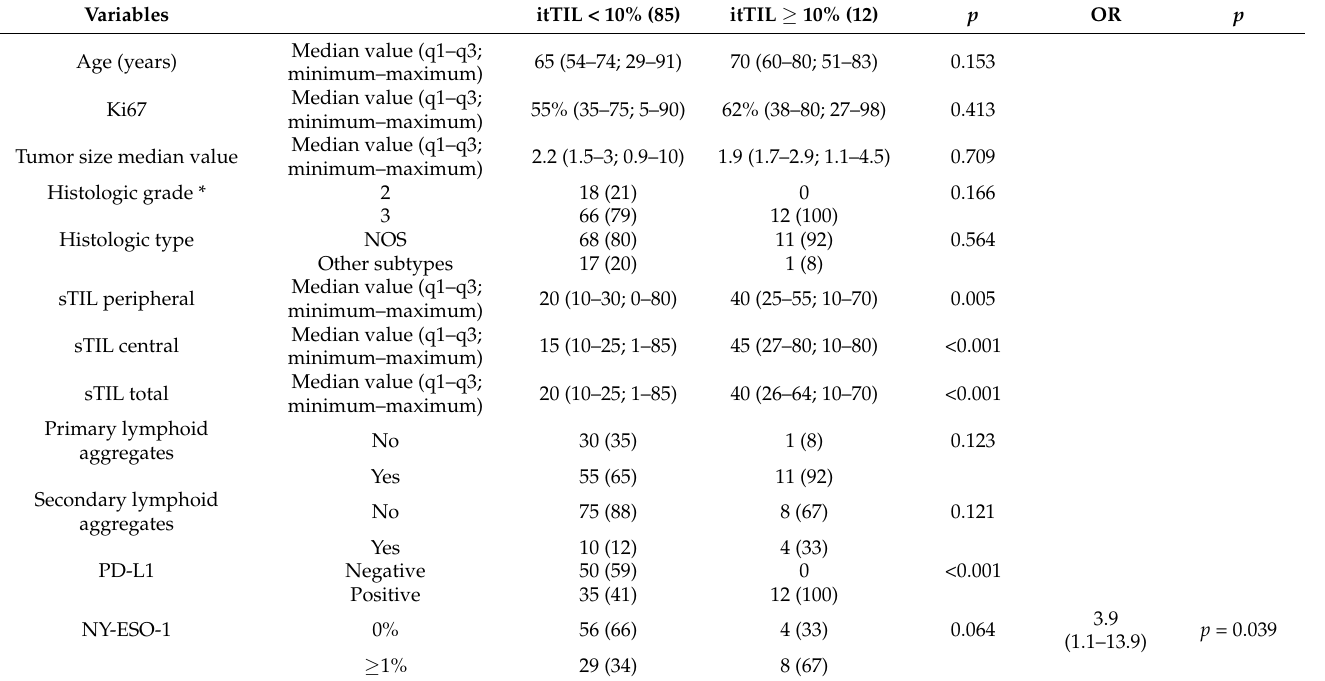
Table 1. Association of the studied variables with intratumoral